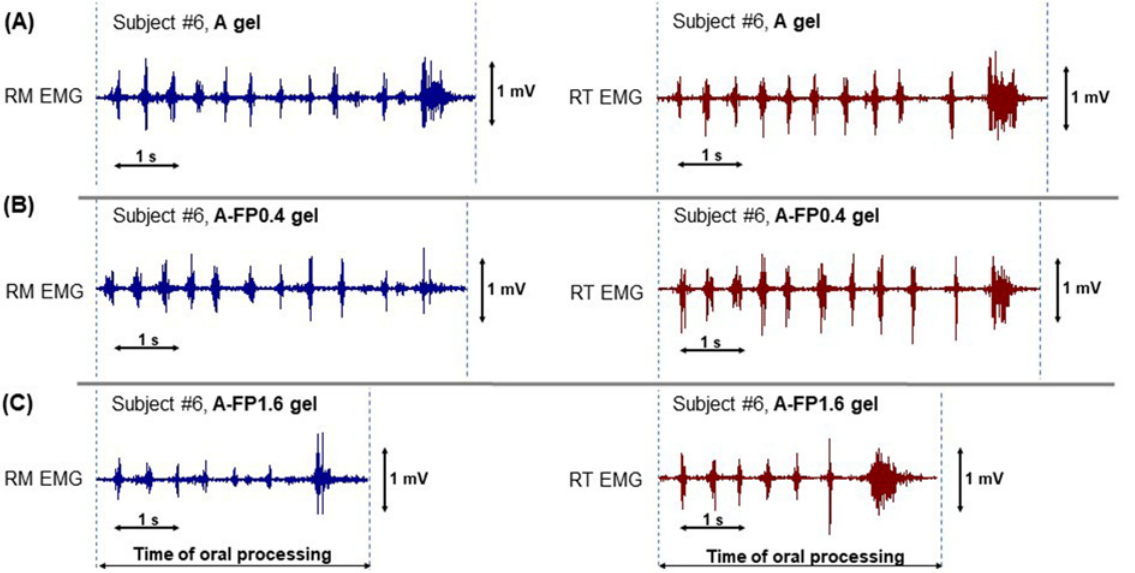
Figure 6. Example of electromyography (EMG) during chewing A ( A ), A-FP0.4 ( B ), and A-FP1.6 ( C ) gels in a representative subject. EMG signals of right masseter (RM) and right temporalis (RT) muscles are recorded. Area between the dotted lines indicates the time of oral processing.